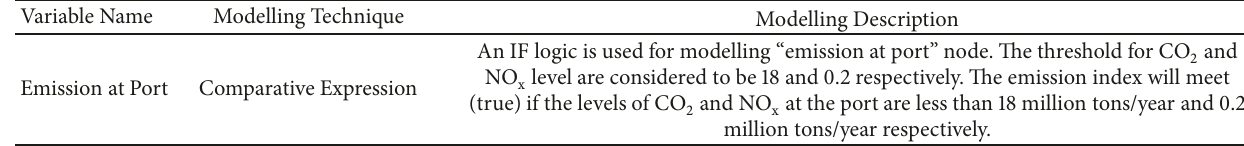
Table 11: Modelling of emission at port variable.